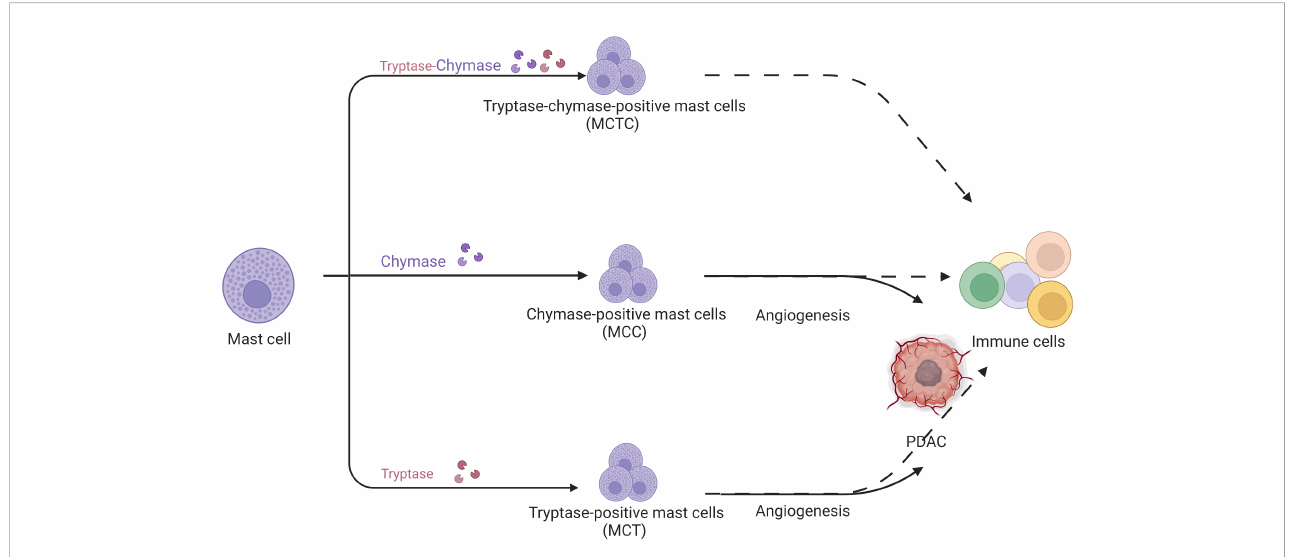
FIGURE 4 Mast cells are divided into tryptase/chymase-positive mast cells, MCCs, and MCTs according to their contents. MCCs and MCTs promote tumor development through their pro-angiogenic effects but their speci fi c role in pancreatic cancer is unknown.